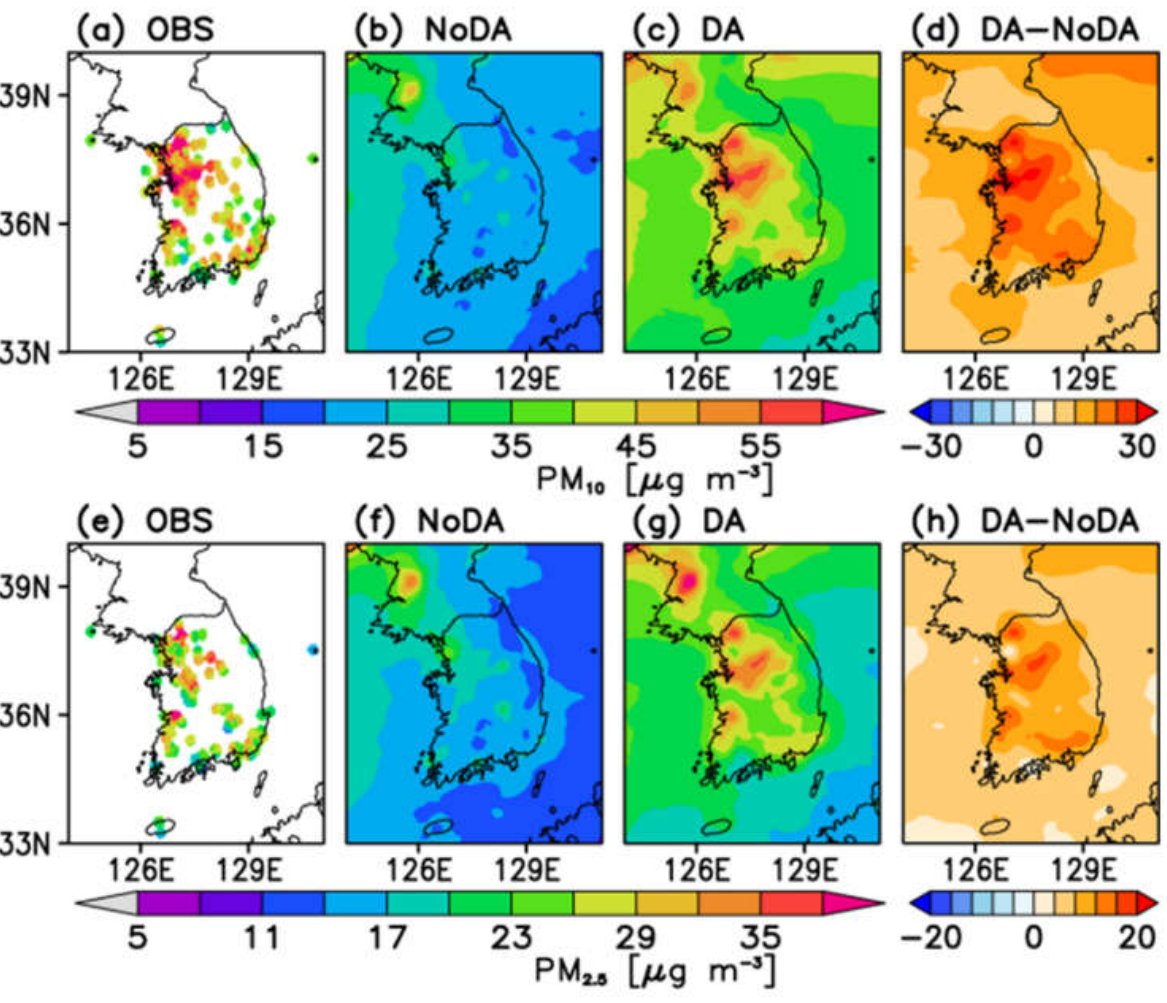
Figure 5. Same in Figure 4 except for Domain